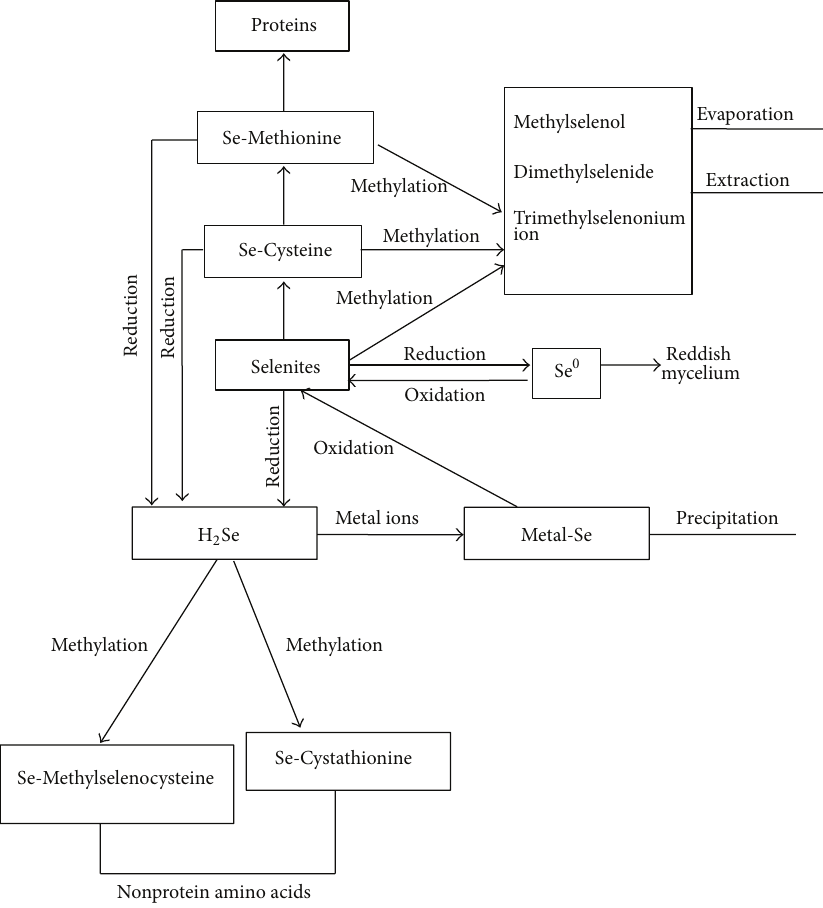
Figure 2: Se metabolism pathways